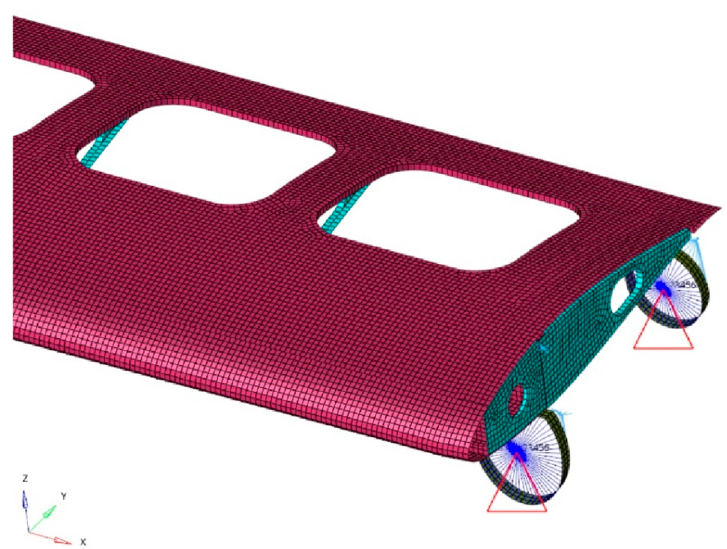
Figure 15. An example of applied restraints.